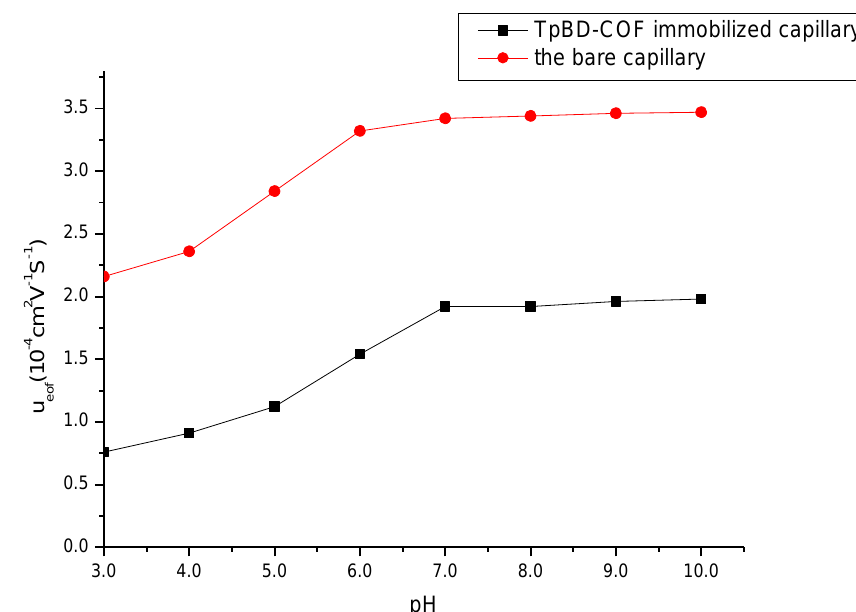
Figure 5. Effect of buffer pH on the electroosmotic flow. Experimental conditions: sample, 5.0 mg/mL benzene; 5.0 mg/mL the mixture solution of benzene, toluene and o-xylene; 20 mM of phosphate buffer solution; operating voltage, 15 kV; temperature, 20 ◦ C.